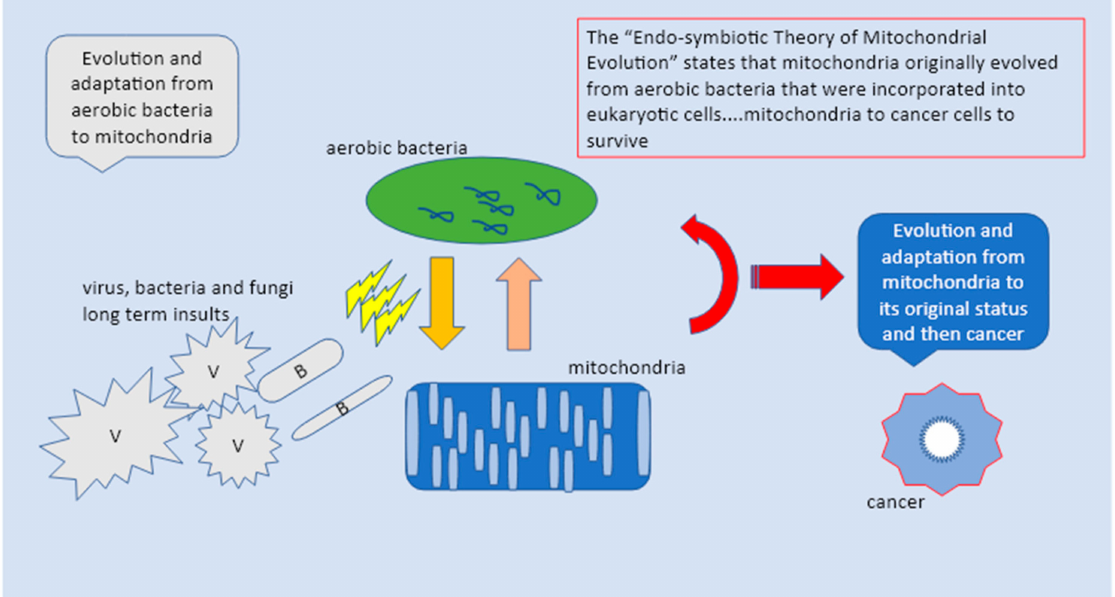
Figure 2. The “Endo-symbiotic Theory of Mitochondrial Evolution” states that mitochondria origi- nally evolved from aerobic bacteria that were incorporated into eukaryotic cells. The mitochondria in response to pathogens return to their original state as independent bacteria and upon constant insults switch into cancer cells to survive the